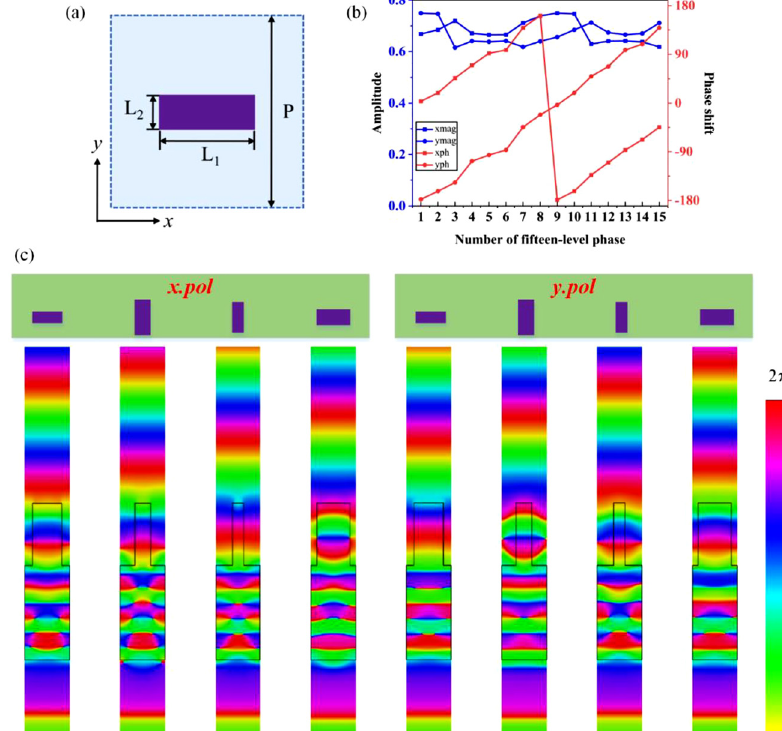
Figure 1: The schematic of a bifunctional metasurface with complete amplitude and phase modulation. For the LCP incidence, the transmitted RCP field contains two foci with an amplitude ratio of 3:2 along x axis. For the RCP incidence, the transmitted LCP fi eld contains two foci with an amplitude ratio of 2:1 along y axis.